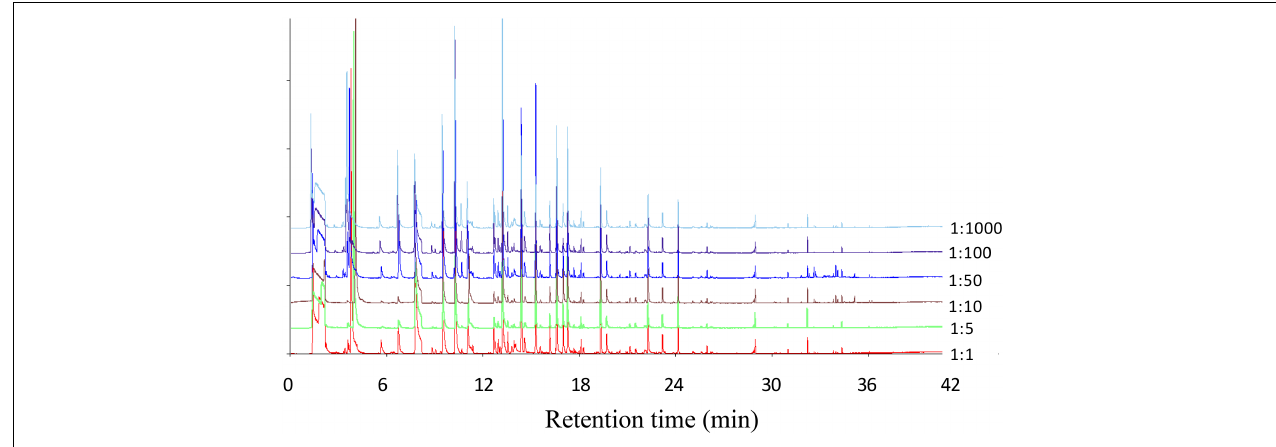
FIGURE 2 | Chromatographic fingerprints of all samples of milk fermented with different ratios of L. plantarum P-8 to starter culture at 0 d of storage.